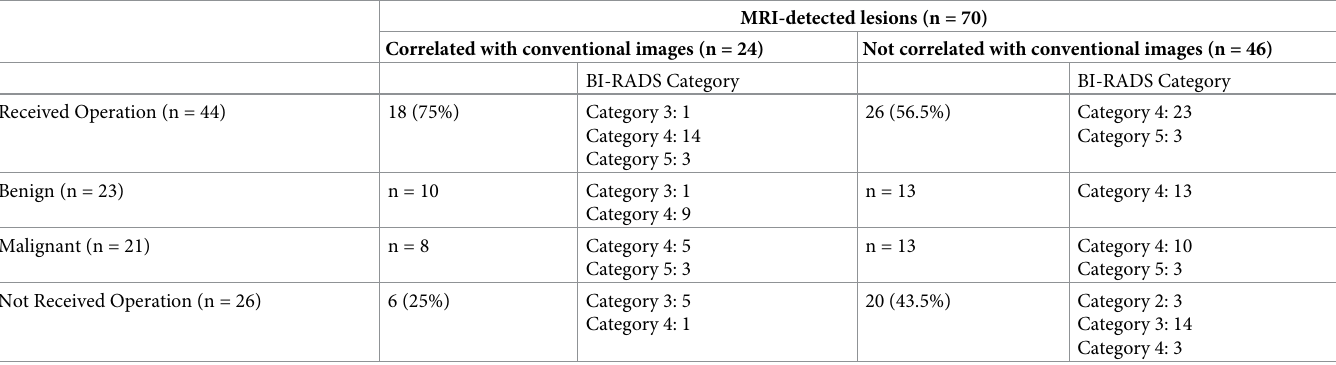
Table 2. MRI detected contralateral lesions correlated to conventional imaging, BI-RADS category, and pathologic